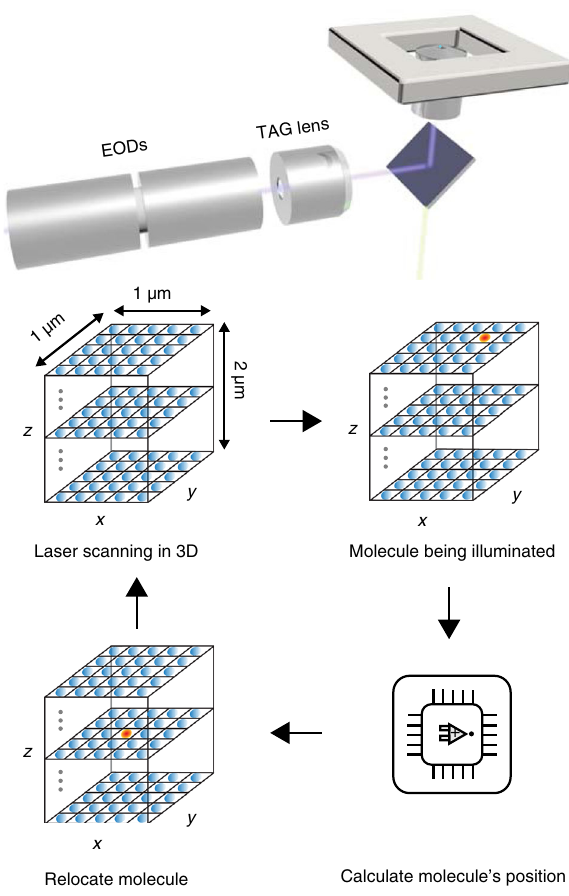
Fig. 1 Overview of real-time 3D single-molecule tracking via 3D-SMART. 3D-SMART is implemented using a 2D-EOD and TAG lens which rapidly scan a focused laser spot over a small volume (1 μ m × 1 μ m × 2 μ m, grid of blue dots). When a molecule is illuminated (red spot), it will emit photons. These photons are collected on an APD and the photon counts and current laser position are used to estimate the molecule ’ s position onboard a fi eld- programmable gate array (FPGA) every 20 μ s. This position is then used in a PID feedback loop to drive the piezoelectric nanopositioner to re-center the molecule in the laser